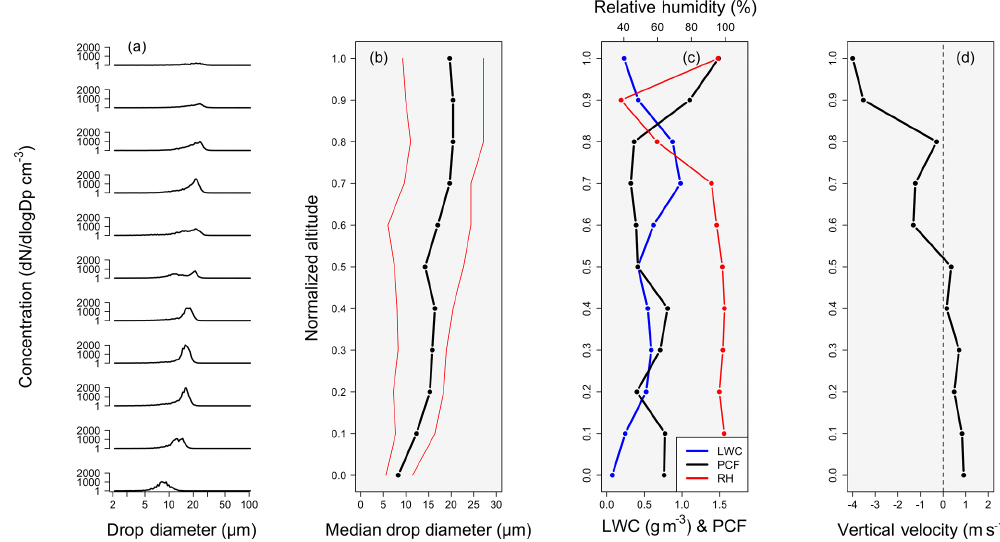
Figure 8. Shows the cloud droplet size distribution in panel (a) . Panel (b) gives the median droplet size along with the 5th and 95th percent quantiles (red) of the droplet size distribution. Panel (c) shows LWC (blue), RH (red), and the mean PCF value (black). Panel (c) shows vertical velocity. All variables are represented as a function of cloud normalized